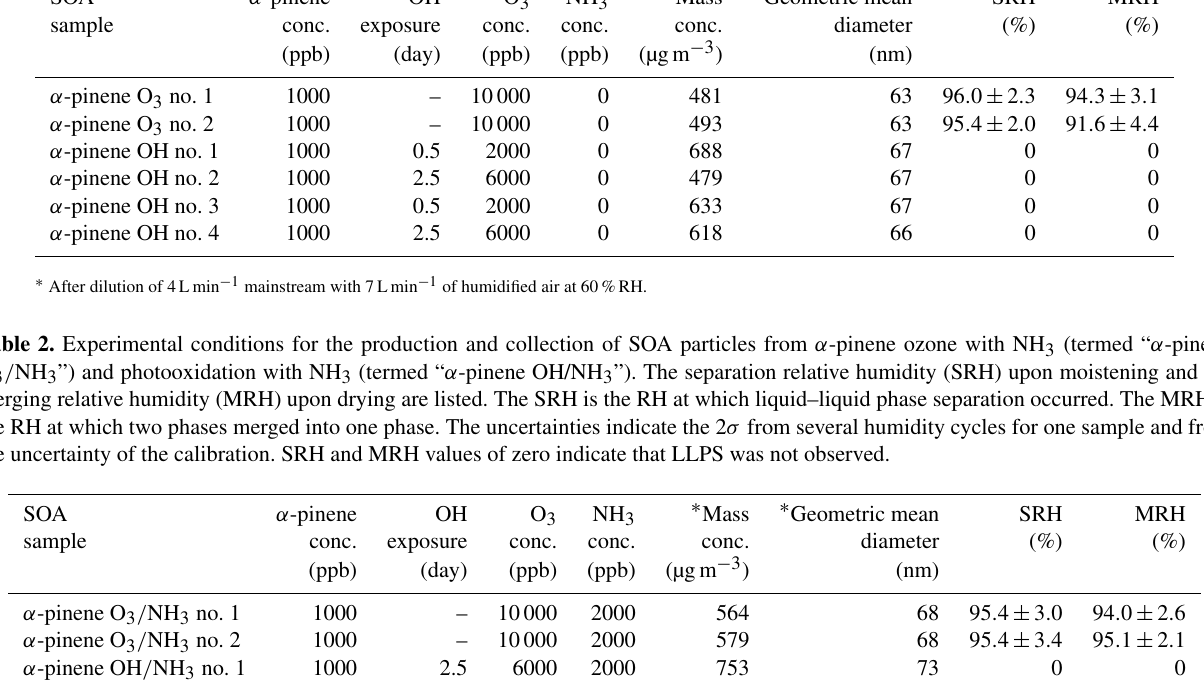
Table 1. Experimental conditions for production and collection of SOA particles from α -pinene ozone (termed “ α -pinene O 3 ”) and photoox- idation (termed “ α -pinene OH”). The separation relative humidity (SRH) upon moistening and the merging relative humidity (MRH) upon drying are listed. The SRH is the RH at which liquid–liquid phase separation occurred. The MRH is the RH at which two phases merged into one phase. The uncertainties indicate the 2 σ from several humidity cycles for one sample and from the uncertainty of the calibration. SRH and MRH values of zero indicate that phase separation was not observed. “conc.” refers to concentration. SOA α -pinene OH O 3 NH 3 ∗ Mass ∗ Geometric mean SRH MRH sample conc. exposure conc. conc. conc. diameter (ppb) (day) (ppb)